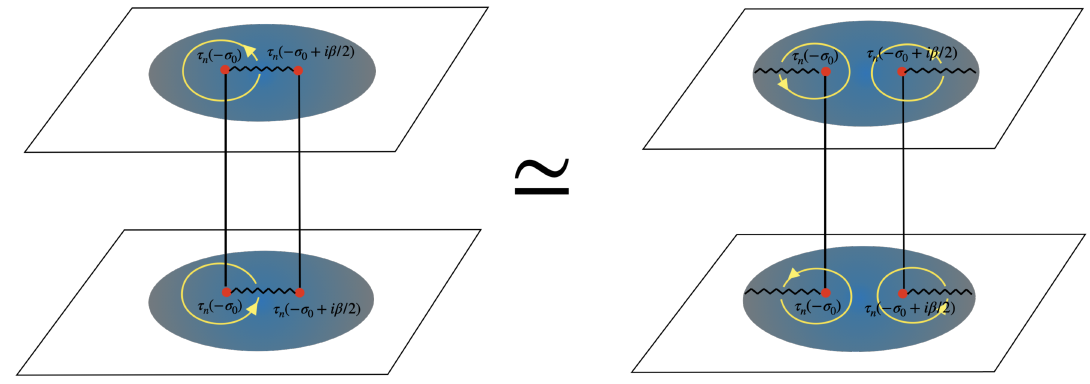
Figure 3 . The replica wormholes in the eternal black hole: the dark blue disk is the 2 d Euclidean space H 2 = EAdS 2 . The space is n -tiply replicated and only two of them are shown. On each H 2 , there is a pair of twist operators τ n of the Liouville CFT (red blobs) corresponding to a pair of cosmic branes that create an n -th root branch cut (black wavy lines) between them (on the left), or alternatively, a pair of branch cuts emanating out to the boundary (on the